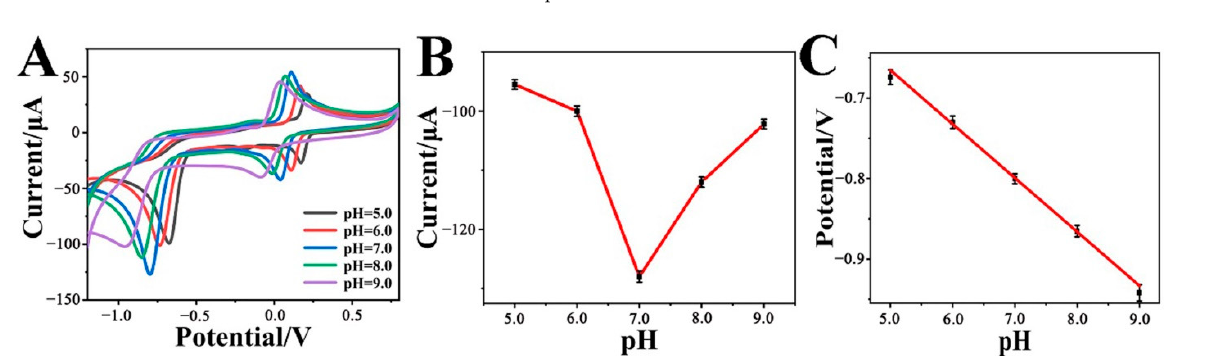
Figure 4. ( A ) CVs, ( B ) reduction peak current versus pH, and ( C ) reduction peak potential versus pH plots of the Cr-MOF/GCE at different pH ranges from 5.0 to 9.0 in 0.1 M phosphate buffer solution with 1 mM p-NP.